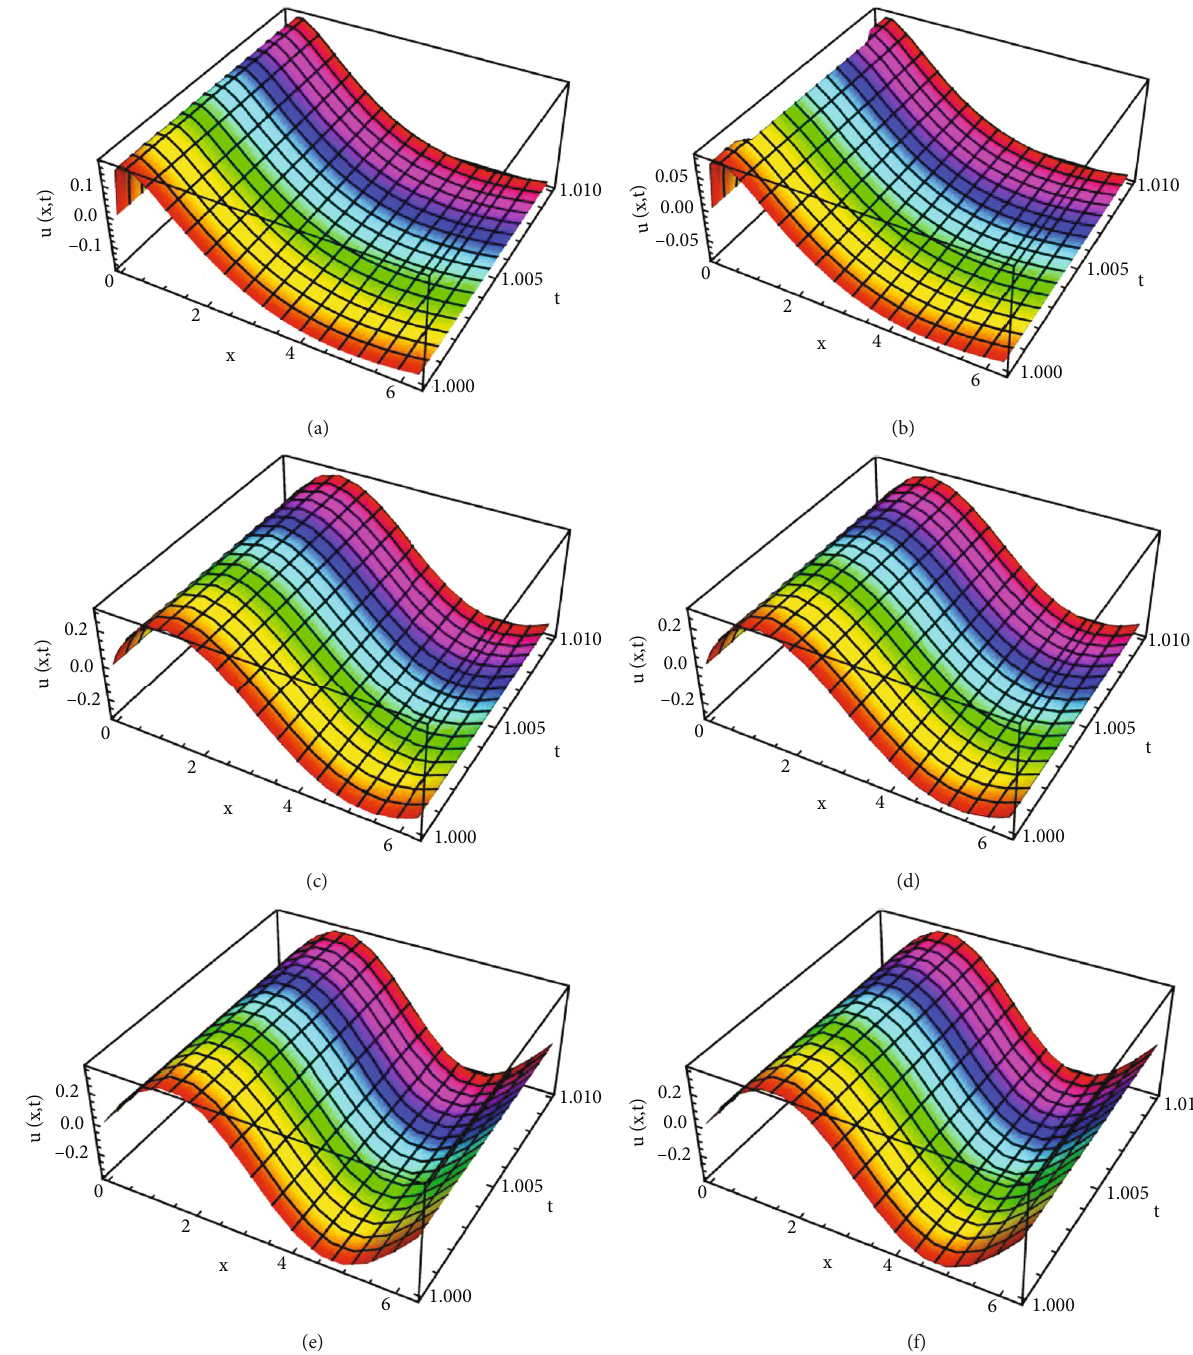
Figure 3: 3D solution plots of Example 3 obtained by the present method (a, c, e) in comparison with the exact solutions (b, d, f) at α = β = 0 : 4 , 0.8, and